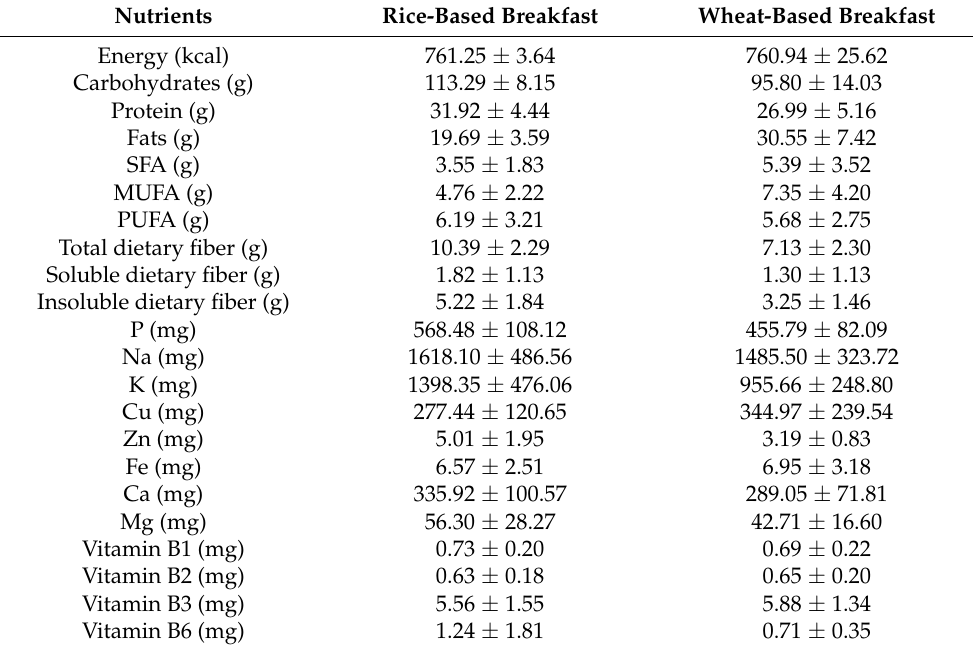
Table 1. The composition of breakfast used in the clinical trial *. Nutrients Rice-Based